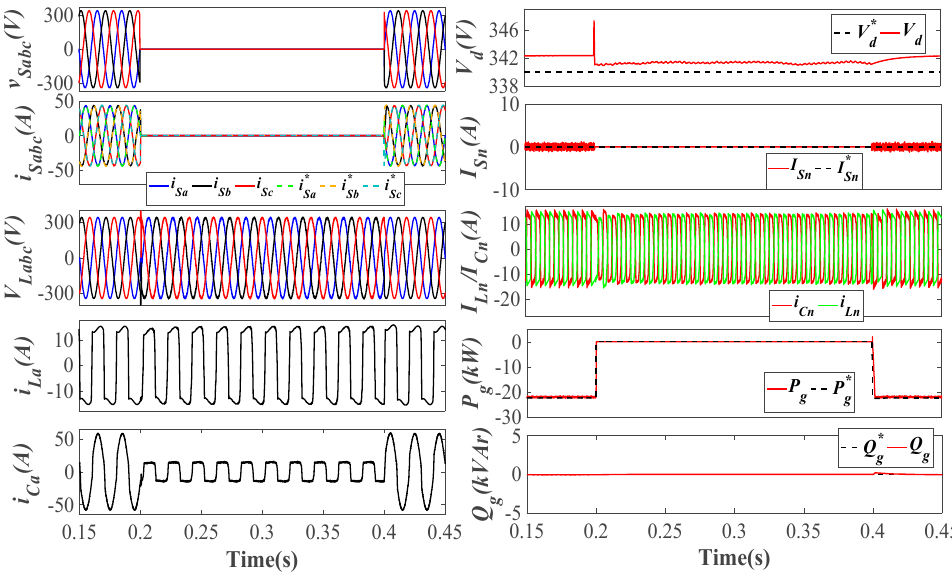
Figure 18. Islanding and re-synchronization analysis of v Sabc , i Sabc , v Labc , i La , i Ca , V d , i Sn , i Cn , i Ln , (cid:2204) P g and Q g .